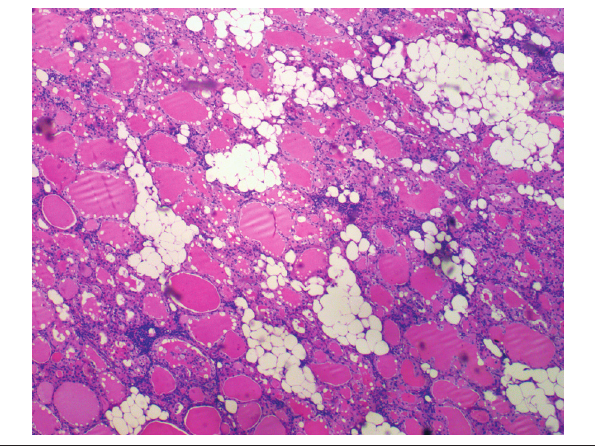
FigurE 2 − Thyroid (HE, 40×): intense lymphocytic infiltrate diffusely associated with adipose tissue sparse within the parenchyma HE: hematoxylin and eosin.